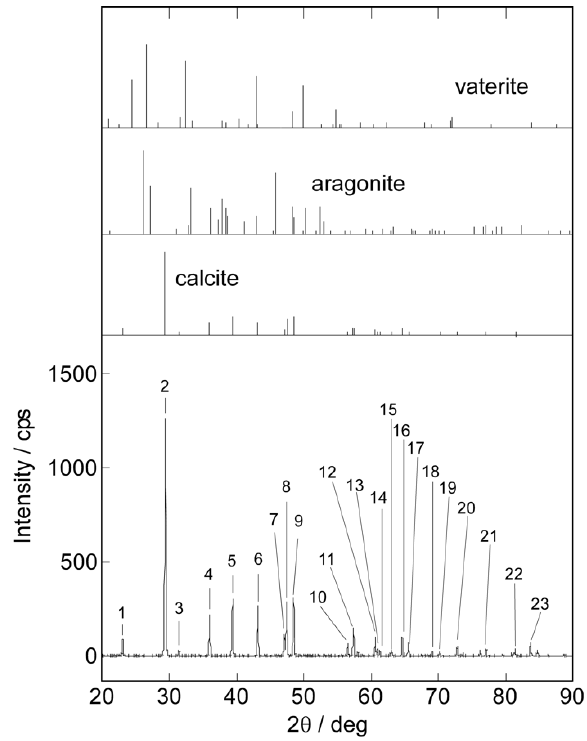
Figure 5. XRD profile of CaCO 3 -coated vesicles after mineralization for 18 days. Standard profiles of calcite, aragonite, and vaterite are shown in this figure, respectively. The assignment of each diffraction peak is shown in Table A1.